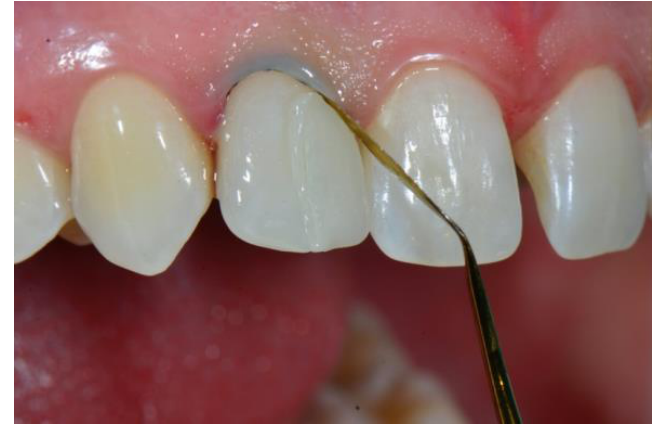
Figure 9. The extra composite is carefully sculpted with an ultrathin spatula. Dent. J. 2019 , 7 , x FOR PEER REVIEW